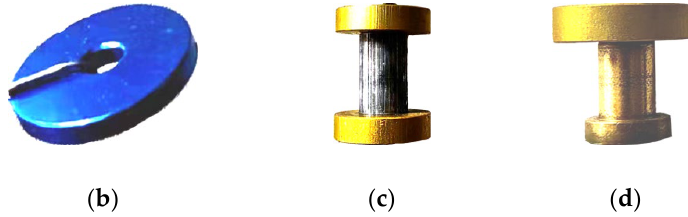
Figure 12. The collection targets of the datasets DB1 to DB4. ( a ) target of DB1 : metal sheet with a thickness of 1 mm; ( b ) target of DB2 : metal sheet with a thickness of 2 mm; ( c ) target of DB3 : symmetrical metal block; ( d ) target of DB4 : asymmetric metal block. Table 1. Training and test dataset.